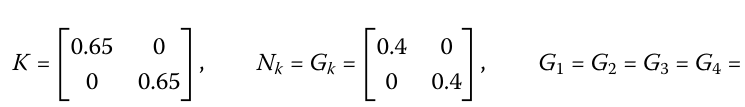
The activation function considered in this example is f ( s ) = s 2 /( s 2 + 1). For η 1 = 0.4, η 2